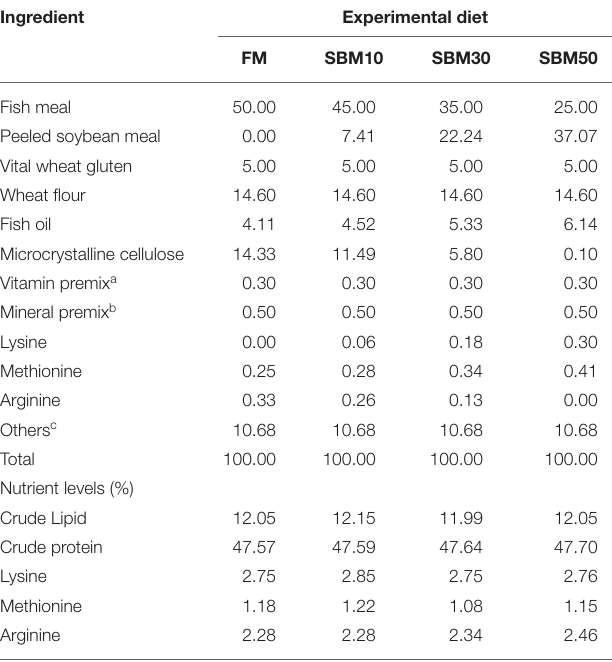
TABLE 1 | Ingredients and nutrient content of the diets (dry weight